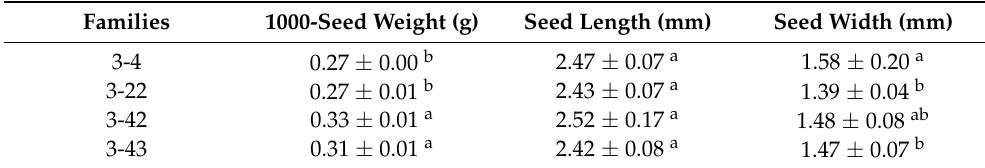
Table 1. Seed traits of different Betula platyphylla families.